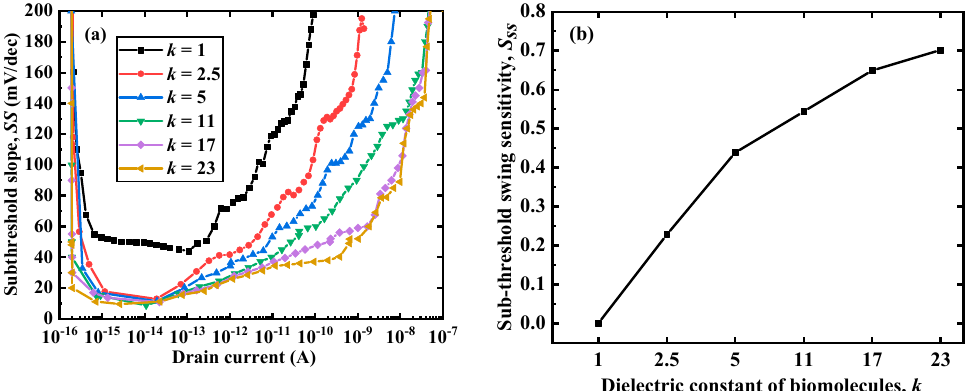
Figure 3. ( a ) SS – I d characteristics and ( b ) S SS of the DM-LTFET with different biomolecules when V d = 0.5 V, T c = 5 nm, and V g = 1 V.